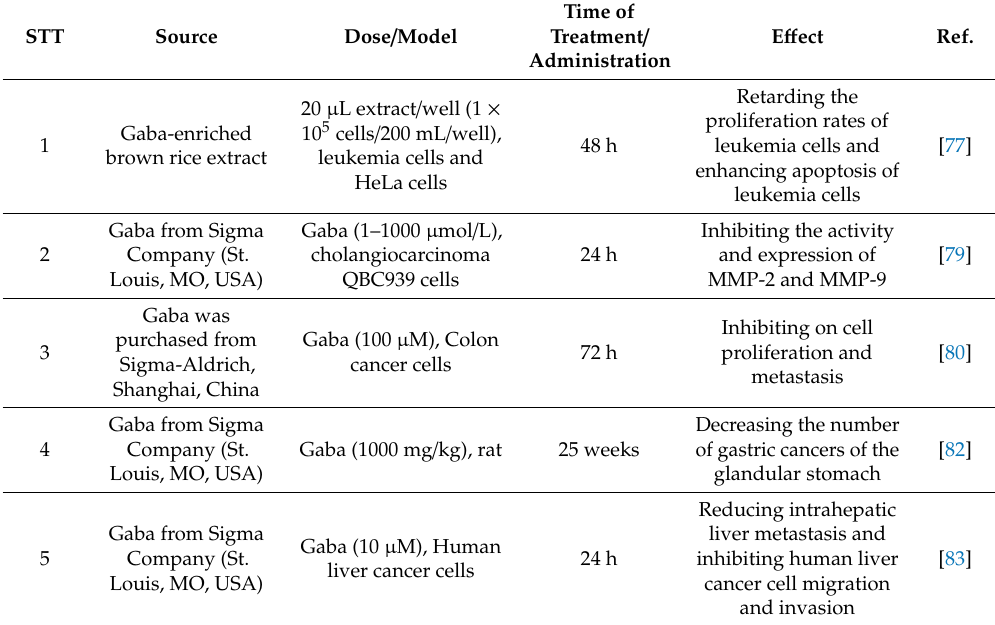
Table 5. Anti-cancer e ff ect of